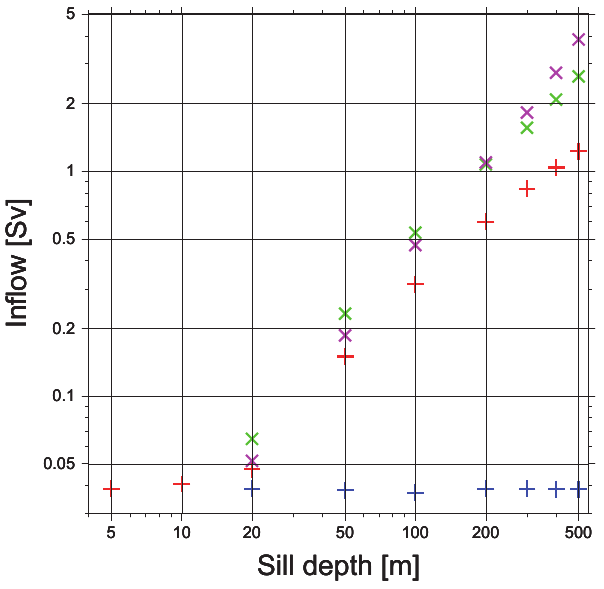
Figure 9. Modelled inflow (red plus signs) and net flow (blue plus signs) in SD500–SD5. Green crosses show the inflow calculated with hydraulic control theory from the basin-averaged densities of the Atlantic and Mediterranean. Purple crosses indicate the inflow calculated with hydraulic control theory using the average density of inflow and outflow in the gateway instead of basin